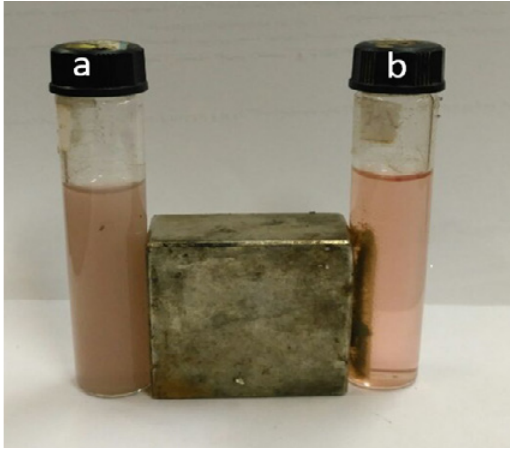
/MWCNT nanoparticles 2 /Fe O /MWCNT magnetic nanocomposite 2 3 4